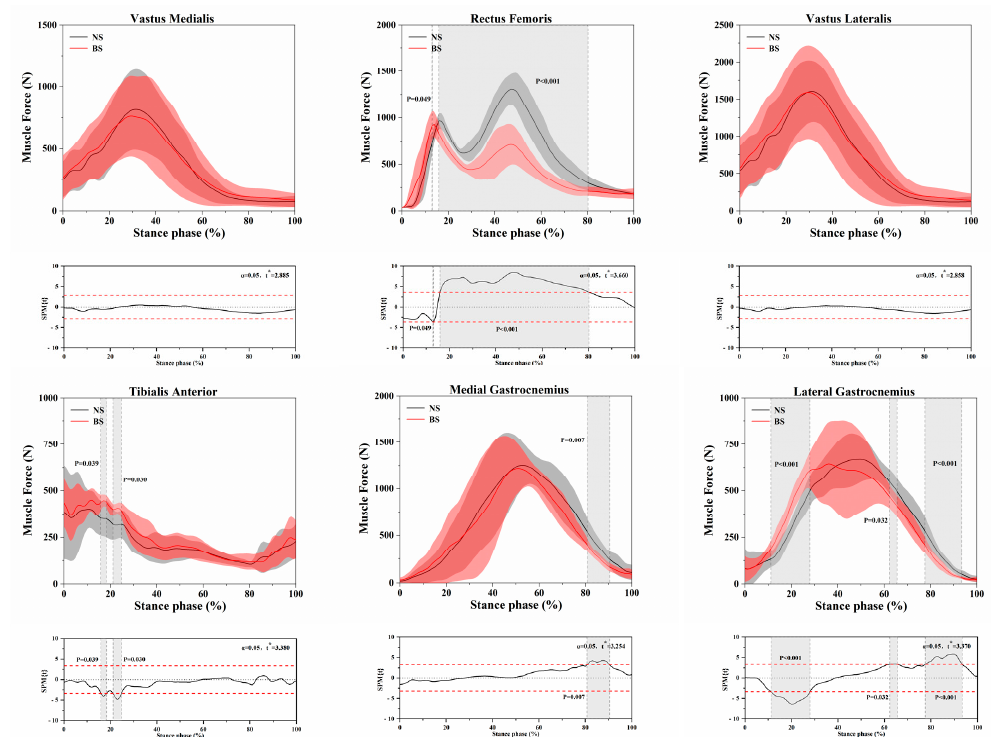
Figure 7. Illustration of the results between the NS and BS lower limb showing the statistical parametric mapping outputs for the medial gastrocnemius, lateral gastrocnemius, vastus medialis, vastus lateralis, rectus femoris, and tibialis anterior during the running stance phase. The muscle force values of t* are shown on the left of each image. Grey shades represent the significant differences and the t -values of the SPM for all participants (post hoc results; dashed red lines represent the results at a p = 0.05 level). NSs, normal shoes; BSs, bionic shoes; N, newton.